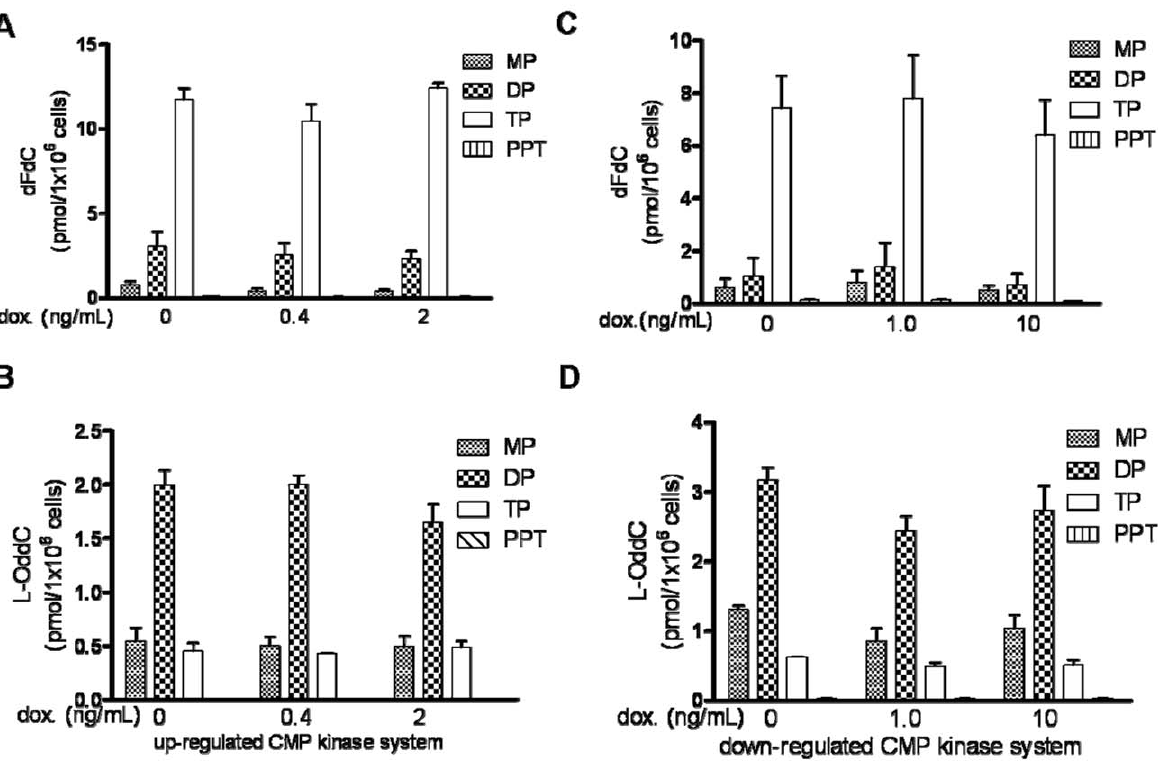
Figure 3. The metabolism of dFdC and L-OddC in cells overexpressing or underexpressing UMP/CMP kinase. A. the content of dFdC mono-, di- and triphosphate in cells overexpressing UMP/CMP kinase. B. the content of L-OddC metabolites in cells overexpressing UMP/CMP kinase. C. the content of dFdC metabolites in cells underexpressing UMP/CMP kinase. D. the content of L-OddC metabolites in cells underexpressing UMP/ CMP kinase.